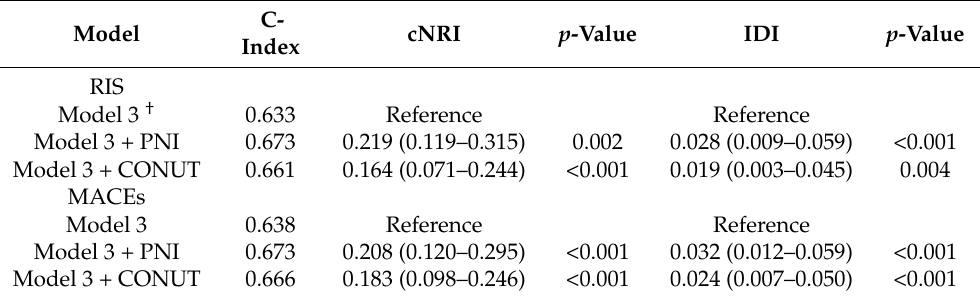
Table 4. Reclassification statistics (95% CI) for RIS and MACEs after the addition of two malnutrition indices.